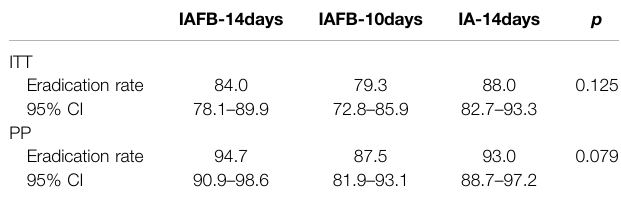
TABLE 2 | Eradication rates in each regimen. TABLE 3 | Variety of adverse events in each